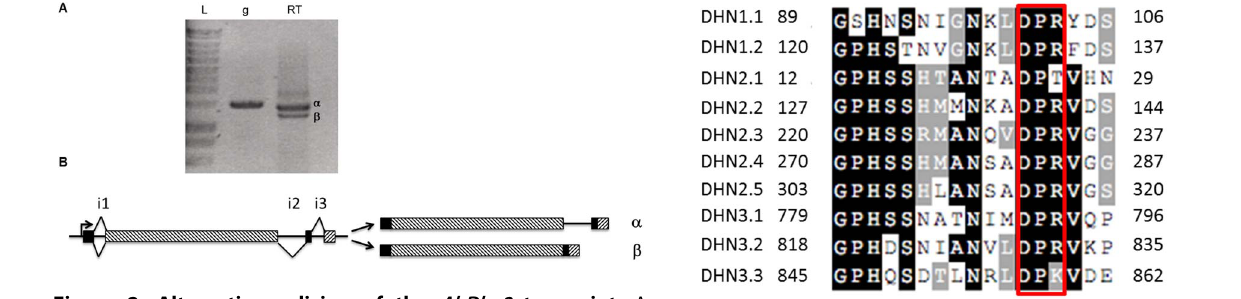
Figure 3. Alignment of the repeated DPR domains of AbDhn1, AbDhn2 and AbDhn3. Conserved amino acids are boxed in black (identical) or grey (similar). DHN1.1–DHN1.2 designate the two domains from AbDhn1, DHN2.1–DHN2.5 the five domains of AbDhn2, and DHN3.1–DHN3.3 the three domains from AbDhn3. Numbers indicate the amino acid positions. The conserved DPR motif is boxed in red.